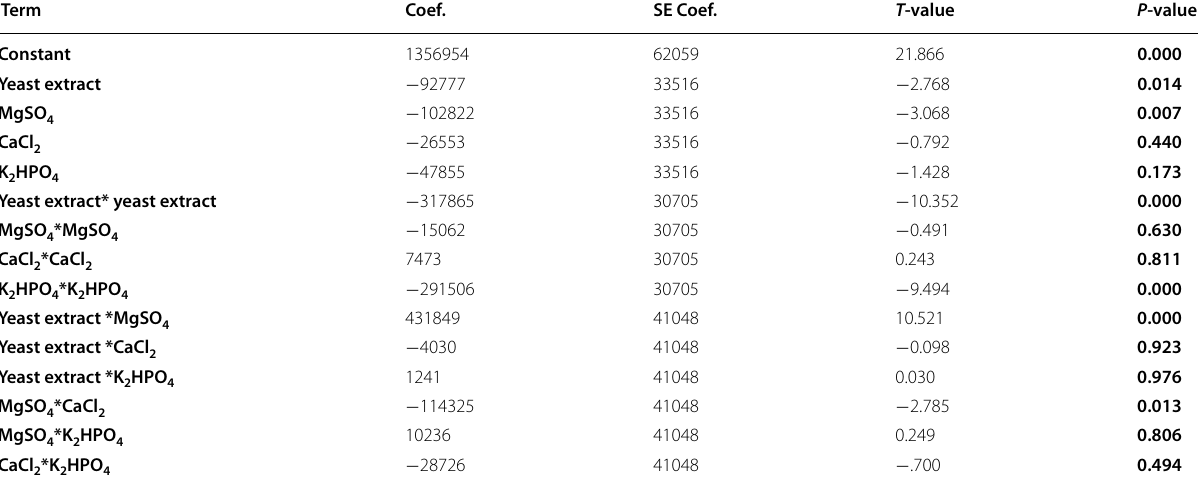
R -Sq 95.3% R -Sq(adj) 91.2% = = required, and herein, it recorded 0.308. To evaluate the probability plot is a useful graphical method to characterize correlation between the tested four parameters and to the nature of the residuals and validate models (Fig. 5). All calculate the highest light intensity corresponding to residuals are close to the diagonal line in a way that indi- the optimal values of yeast extract, CaCl 2, MgSO 4 , and cates they are normally distributed. In the residual plots, all K 2 HPO 4 , the equation of the second-order polynomial residuals are randomly and uniformly scattered against the fitted values of the model. Therefore, all previous evidence reflects a good model fit and affirms the model’s adequacy. mum bioluminescence intensity was predictable: • Graphical plots for interaction effect representation